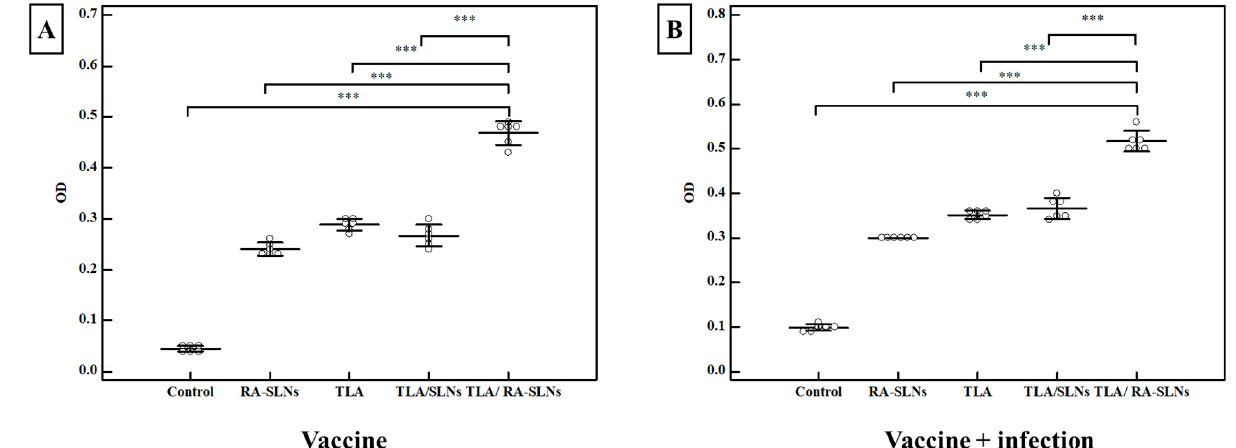
Figure 6. The Toxoplasma -specific IgG titers in sera (OD) among various evaluated regimens. ( A ) The total IgG antibody titers in mice sera two weeks after the second booster dose of immunization (vaccine only). ( B ) The total IgG antibody titers in mice sera at the 4th week following infection challenge (vaccine + infection). Data were conveyed by using mean ± SD. ***: statistically significant at p ≤ 0.001.